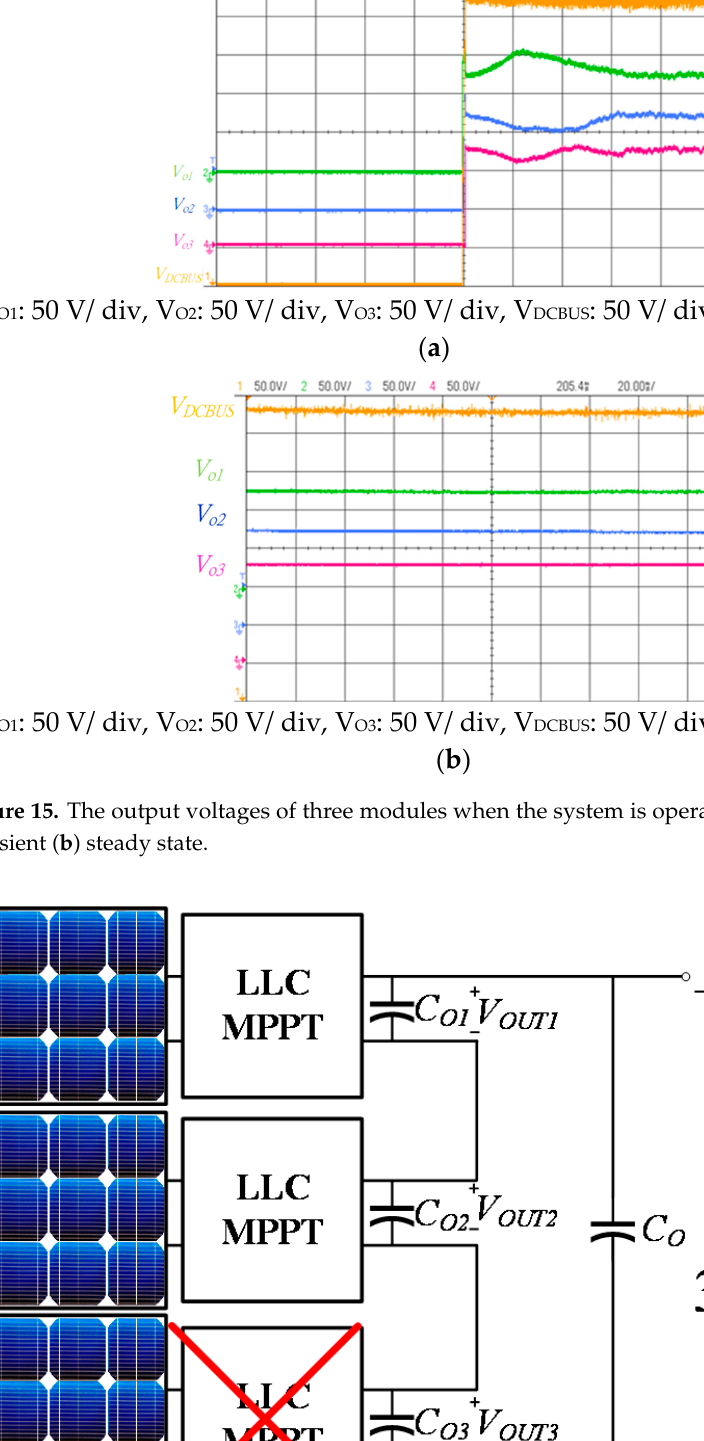
Figure 16. The system is operated in abnormal mode.